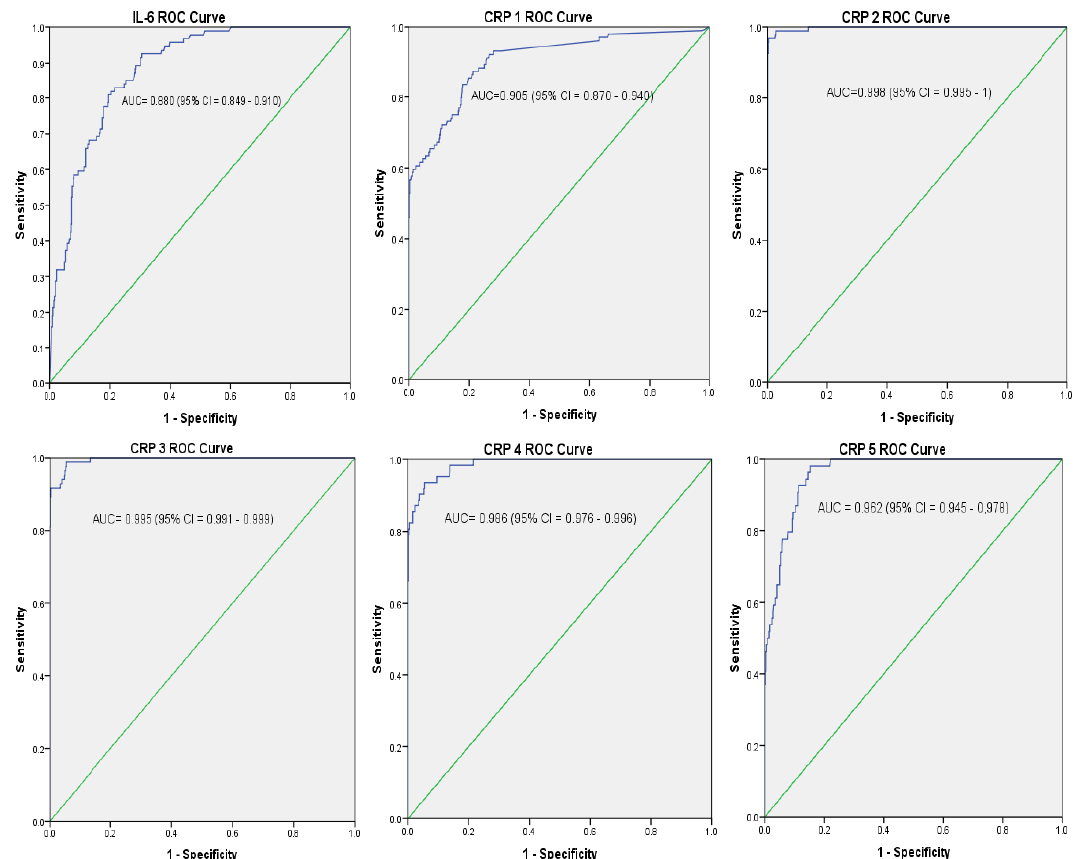
Figure 1. The receiver operating characteristic (ROC) curves for IL-6 and CRP tests drawn from sensitivity versus 1-specificity using culture proven sepsis cases and controls. ROC shows the performance of a test at all classification thresholds. AUC = area under the ROC curve. AUC provides an aggregate measure of performance of a test across all possible classification thresholds. AUC indicates the accuracy of IL-6 or CRP to correctly classify sepsis cases from controls. An AUC of 1 represents a perfect test; 0.90–1 = excellent, 0.80–0.90 = good; 0.70–0.80 = fair; 0.60–0.70 = poor; 0.50–0.60 = fail and an AUC of 0.5 represents a worthless test. CI = Confidence interval. The optimal cut-off values, diagnostic sensitivity, specificity, PPV, and NPV of IL-6 and CRP of proven sepsis versus controls are presented in Table 3. The optimal cut-off levels of IL-6 and the five days serial measurements of CRP were identified based on the results of sensitivity and 1-Specificity of the coordinates of the ROC curve. The optimal cut-off value of IL-6 among proven sepsis versus controls was 313.5 pg/mL. The optimal cut-off values of the 5 days serial measurements of CRP among proven sepsis: CRP1, CRP 2, CRP3, CRP4, and CRP5 were 2.15 mg/L, 8.01 mg/L, 6.80 mg/L, 5.25 mg/L, and 3.72 mg/L, respectively.